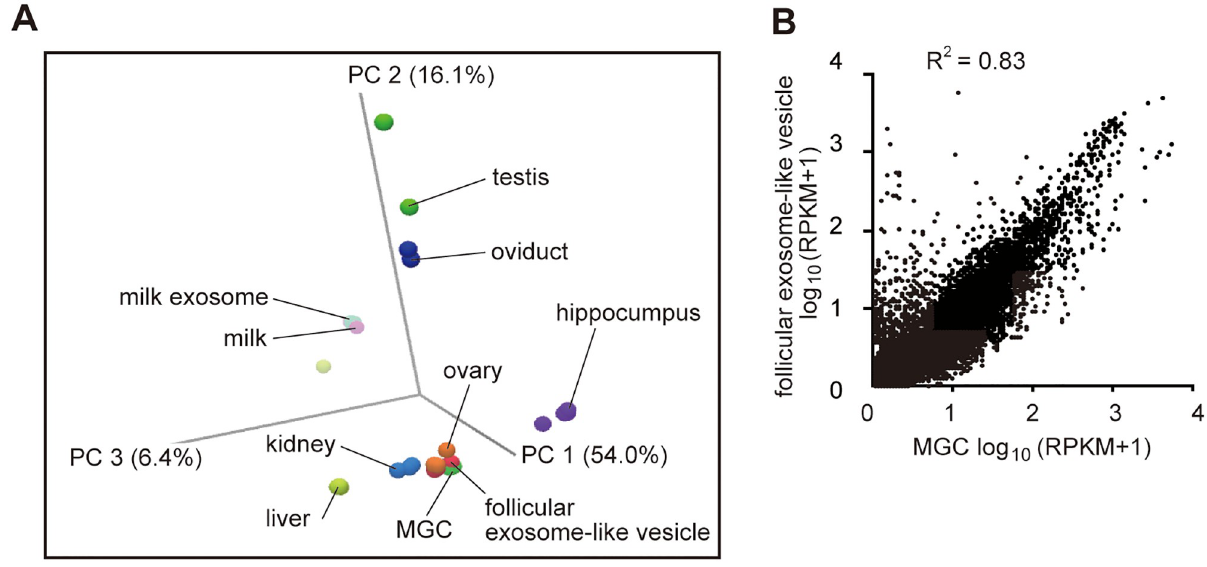
Fig 4. Comparisons of the mRNA profiles between exosome-like vesicles and mural granulosa cells (MGCs) in porcine follicles. (A) Principle component analysis (PCA) of the mRNA profiles of the follicular exosome-like vesicles and MGCs together with other porcine organs (see S1 Table for detail). (B) Scatter plot comparison of mRNA profiles of follicular exosome-like vesicles and